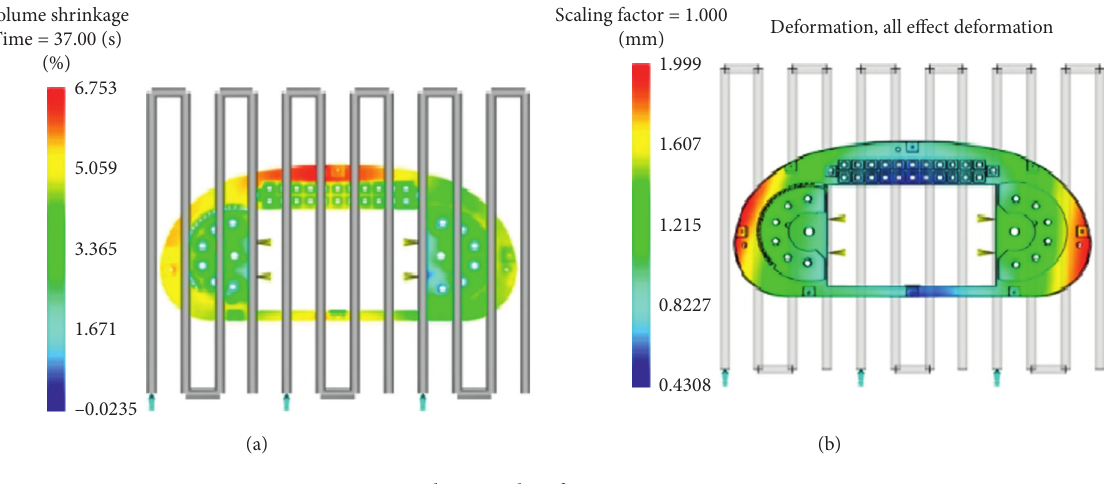
Figure 12: Analysis results of A 1 B 1 C 4 D 4 E 4 parameter. Table 9: Comparison of quality evaluation indices of the Taguchi orthogonal test and the grey correlation